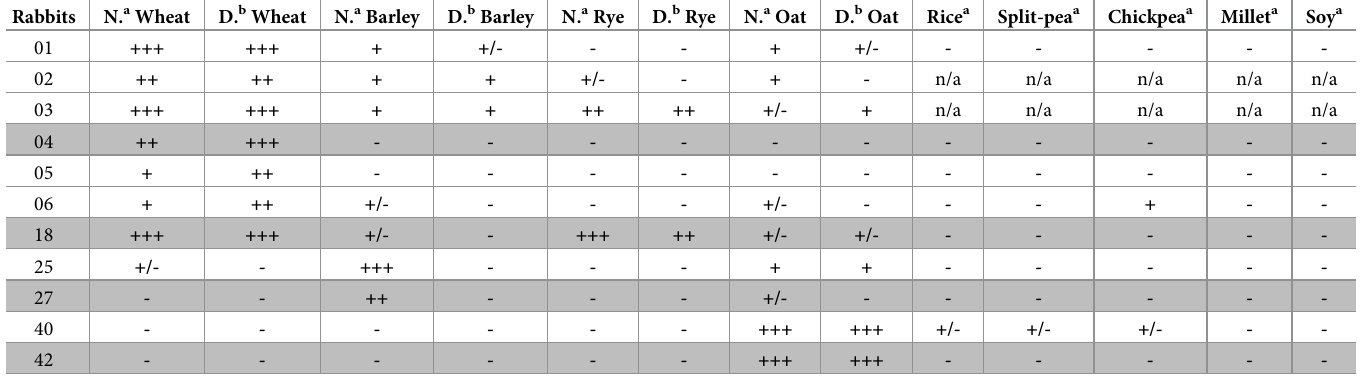
Table 3. Cross-reaction test by indirect